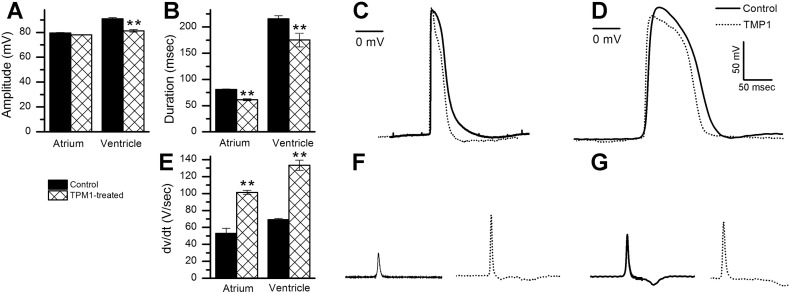
TPM1-MO treatment alters action potentials in cardiomyocytes.A–D. Graphs showing changes in AP amplitude (A) and duration (B) between atrial and ventricular cardiomyocytes in control and TPM1-MO hearts. Representative AP traces from atrial (C) and ventricular cardiomyocytes (D) for control (black traces) and TMP1-treated (dotted traces) hearts were superimposed to show amplitude and duration changes.E–G. Graphs showing changes in the rate of depolarisation (δv/δt) of the atrial and ventricular cardiomyocytes from control and TPM1-MO hearts (E). Representative AP traces of the maximal δv/δt from both atrial (F) and ventricular (G) cardiomyocytes for control (black traces) and TPM1-MO hearts (dotted traces) are shown.